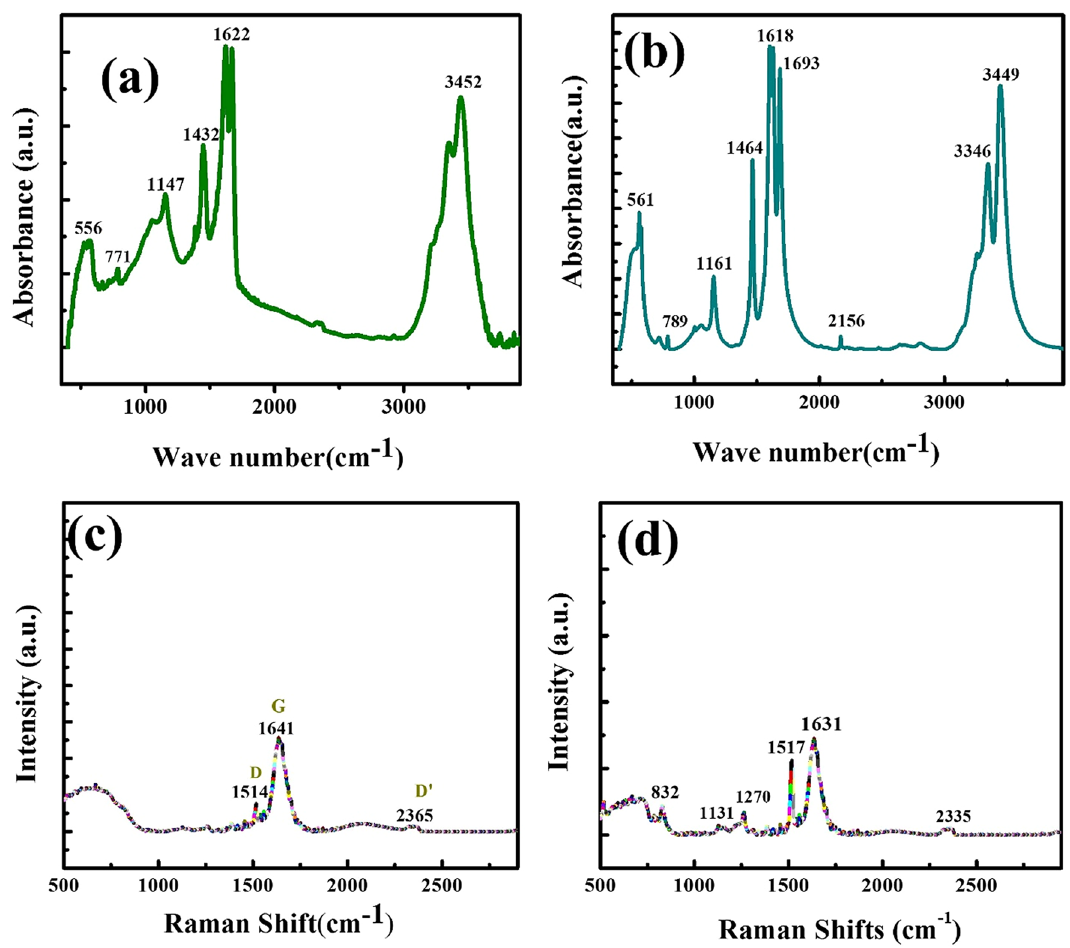
Figure 2. ( a , b ) FTIR and ( c , d ) Raman results of the N-MWCNT and N-MWCNT/CMC composites.